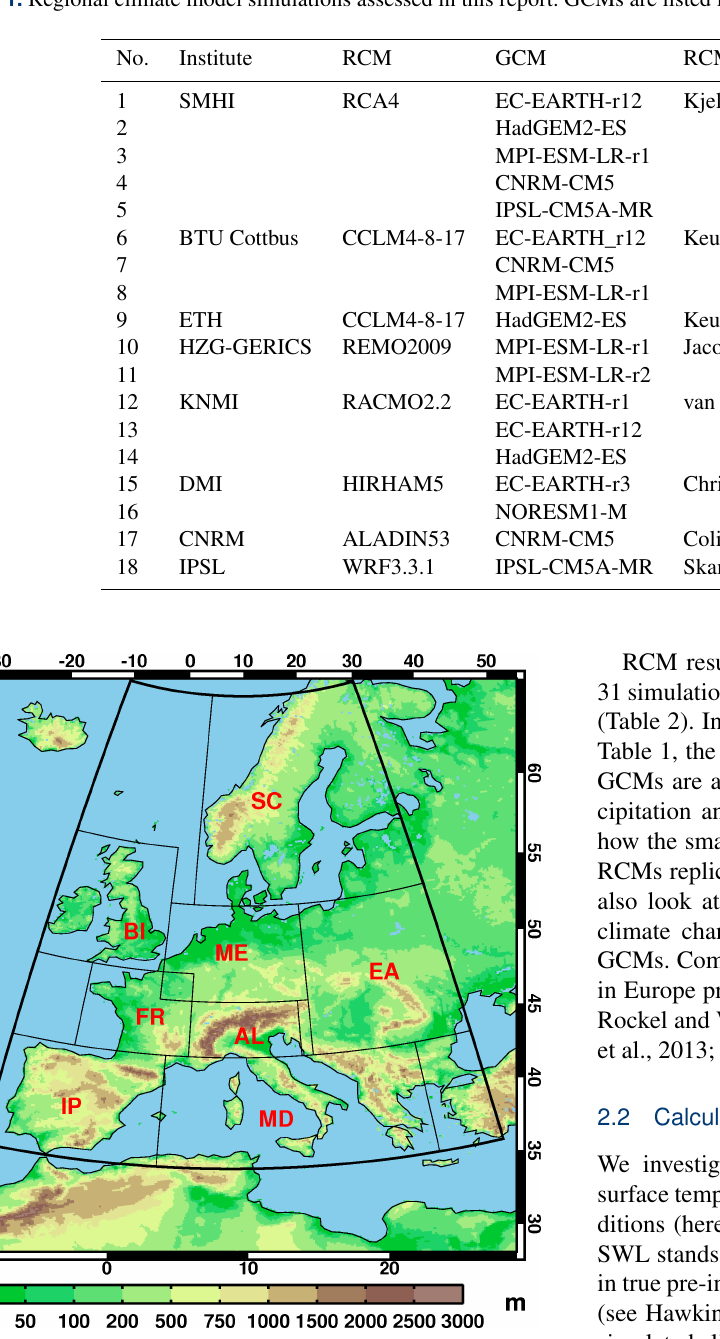
Table 1. Regional climate model simulations assessed in this report. GCMs are listed in more detail in Table 2.